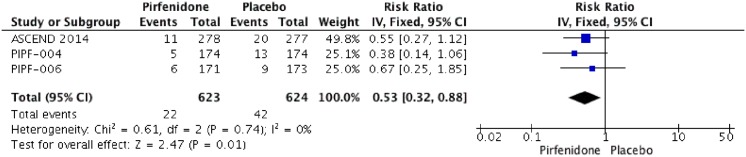
Comparison 1.All cause-mortality at week 52.